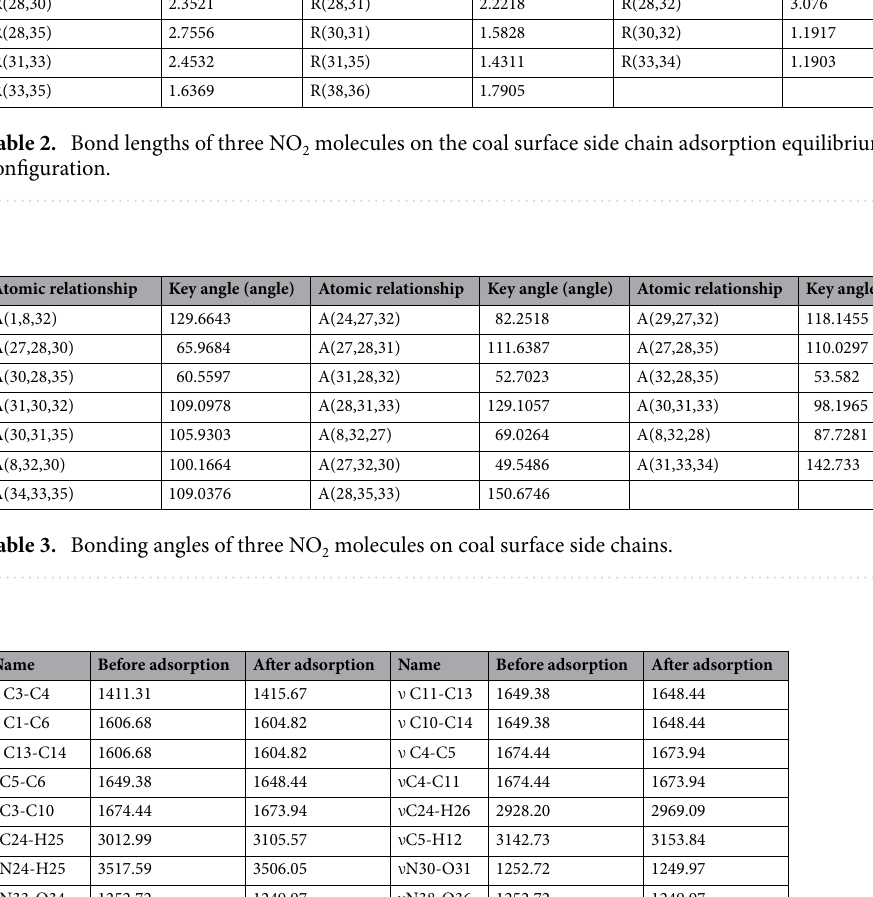
Table 4. Comparison of infrared spectrum frequency before and after adsorption of three NO 2 molecules and coal surface side chain (cm −1